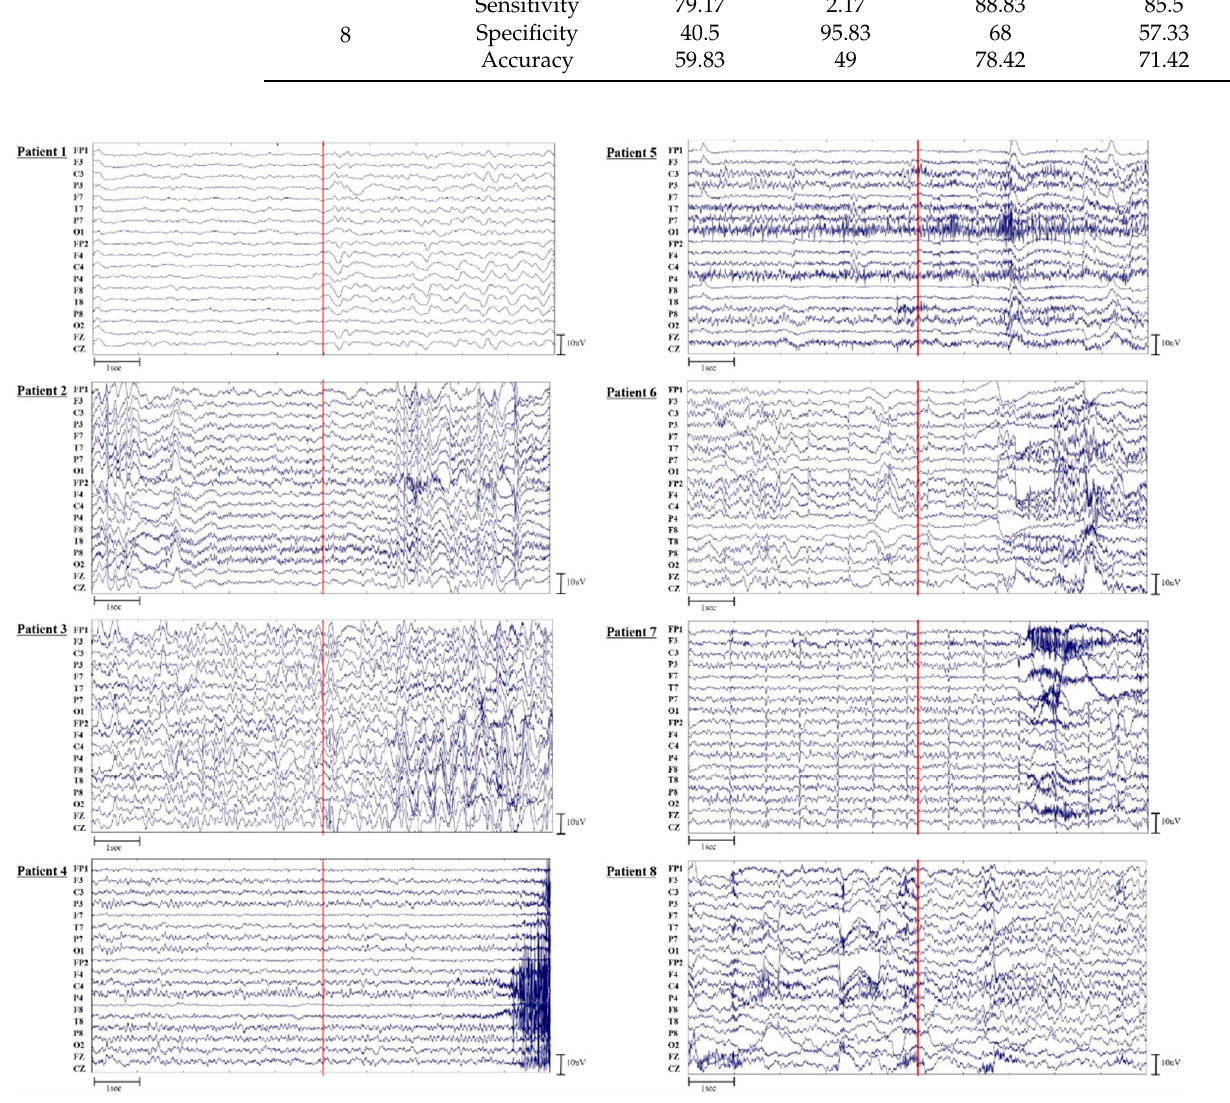
Figure A1. The raw EEG data of all patients. Table A1. Performance of CGRU with channel reduction based on attention score.